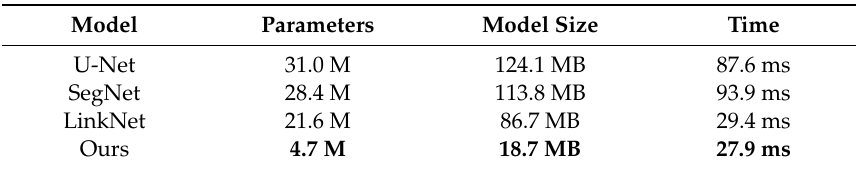
Table 5. Comparison of di ff erent architectures implementation on NVIDIA Xavier. (The best results are